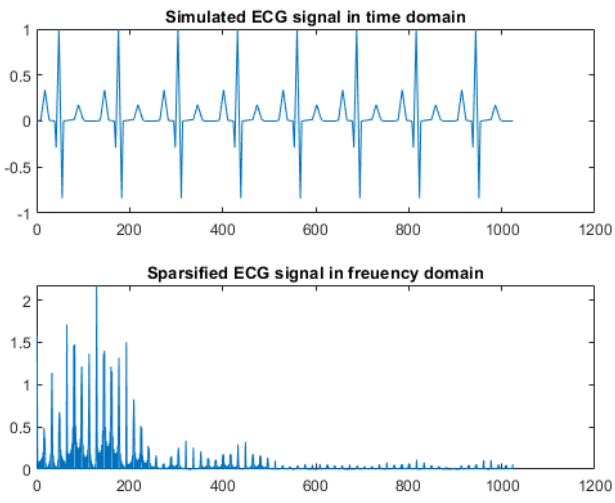
Figure 6. Original and Sparse representation of the ECG